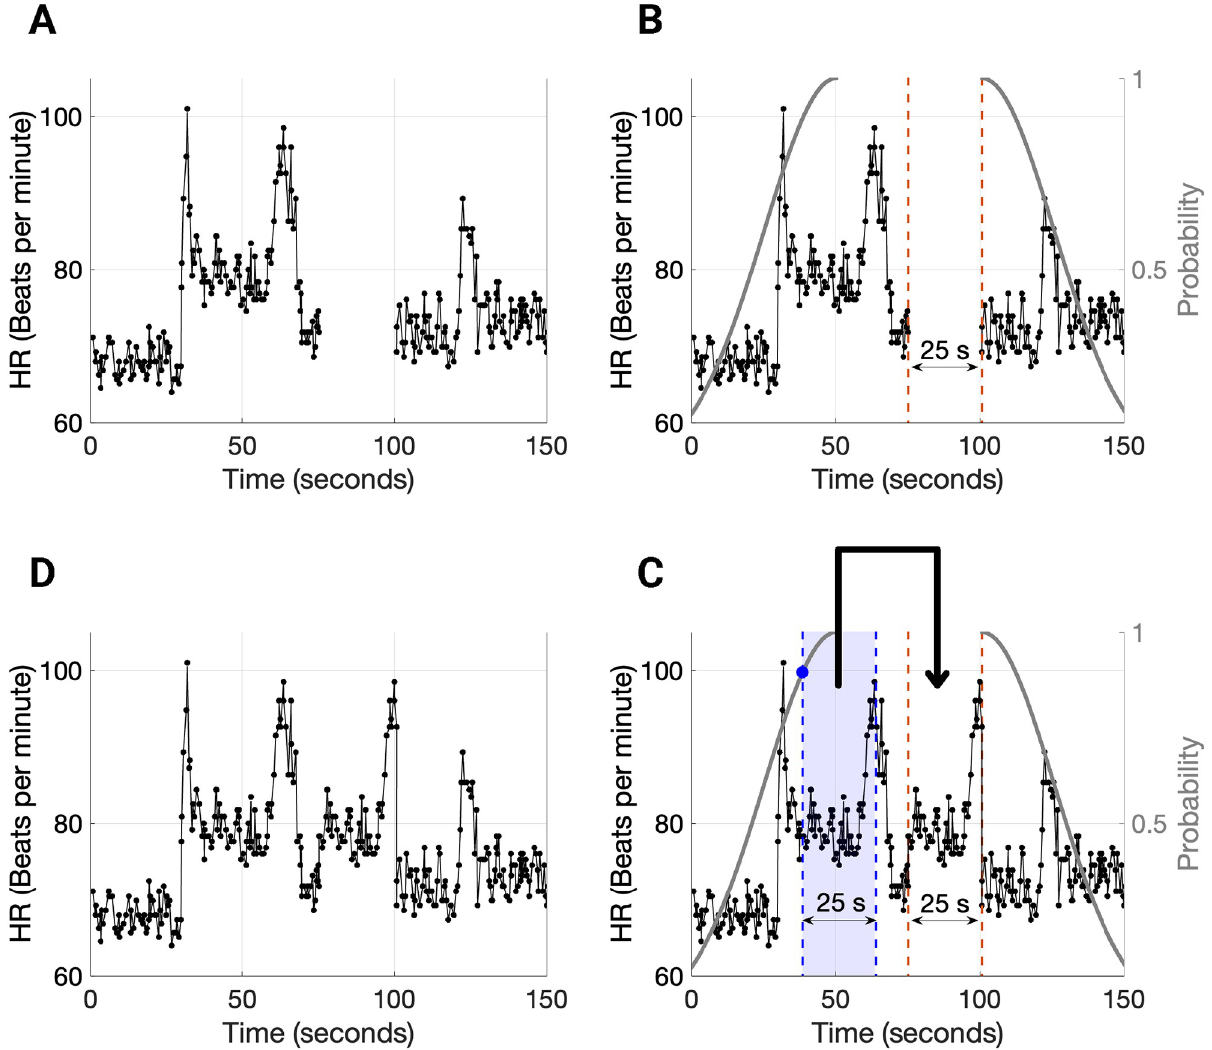
Fig 3. Stochastic surrogate data imputation technique fills gaps in heart rate (HR) and activity count signals by choosing a contiguous HR segment in the gap’s neighborhood of the same length as the gap. (A) We illustrate an example HR signal with missing data. (B) The HR signal contains a 25-second-long gap that has been identified. Based on the boundaries and length of the gap, two folded normal distributions are constructed for stochastically choosing a 25-second-long HR segment. (C) We perform a coin toss experiment, and based on the outcome, we sample from one of the two folded normal distributions and accordingly select a contiguous 25-second-long HR segment and copy it over to the gap. Further, we add a small noise to this imputed signal (we do not show it in the figure for convenience). (D) The imputed HR signal with no gaps.